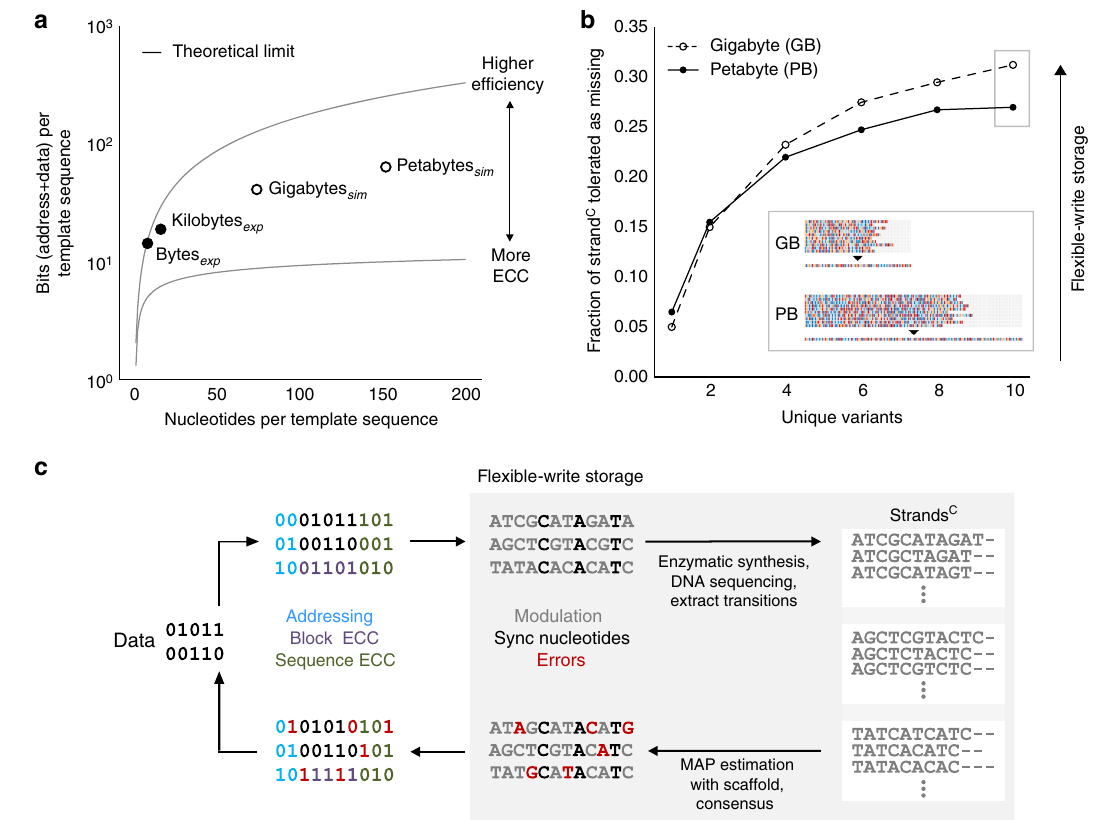
Fig. 5 A roadmap for scaling DNA storage systems. a Ef fi ciency of storage for experimental and simulated systems. Experimental systems (black) include storing 12 bits in 8-nucleotide template sequences, and 16 bits in 16-nucleotide template sequences. Simulated maximum storage systems (white circles) include gigabyte scale that stores 36 bits in a 74-nucleotide template sequence, and petabyte scale that stores 57 bits in a 152-nucleotide template sequence. The amount of bits stored per sequence is dependent on the amount of error-correction codes (ECC) that are applied. Reducing ECCs increases the ef fi ciency rate of storage. The upper bound theoretical limit represents a maximum ef fi ciency of storage of ~ 1.58 bits per transition between non- identical nucleotides (Supplementary Note 2). The lower bound theoretical limit represents the minimum number of bits per template sequence that must be stored for only addressing (Supplementary Note 4). See all tested storage systems in Supplementary Table 8. b Flexible-write storage is enabled by a codec, which harnesses diversely synthesized strands. The decoding pipeline supports robust data retrieval from synthesized strands with a signi fi cant percentage of errors. Inset: with ten strand C variants, each with ~ 30% missing nucleotides, the correct decoded sequence can be reconstructed for both gigabyte- and petabyte scale maximum storage capacities. c A system architecture for storing information in enzymatically synthesized DNA. A bitstream is partitioned into rows, each augmented with an address to delineate its order for reassembly. An ECC such as a Bose – Chaudhuri – Hocquenghem (BCH) code can be applied to each row, or an ECC such as a Reed – Solomon (RS) code can be applied across multiple rows, to protect data from errors (Supplementary Note 2). Modulation consists of mapping sequences of bits to template sequences, which includes synchronization nucleotides. Enzymatic synthesis then produces multiple diverse strands C per template sequence. The resulting strands C are used for sequence reconstruction based on MAP estimation and probabilistic consensus. Subsequently, the reconstructed sequence is demodulated into bits. Error-correction is applied to ensure data retrieval. Source data for b are provided in the Source Data fi le